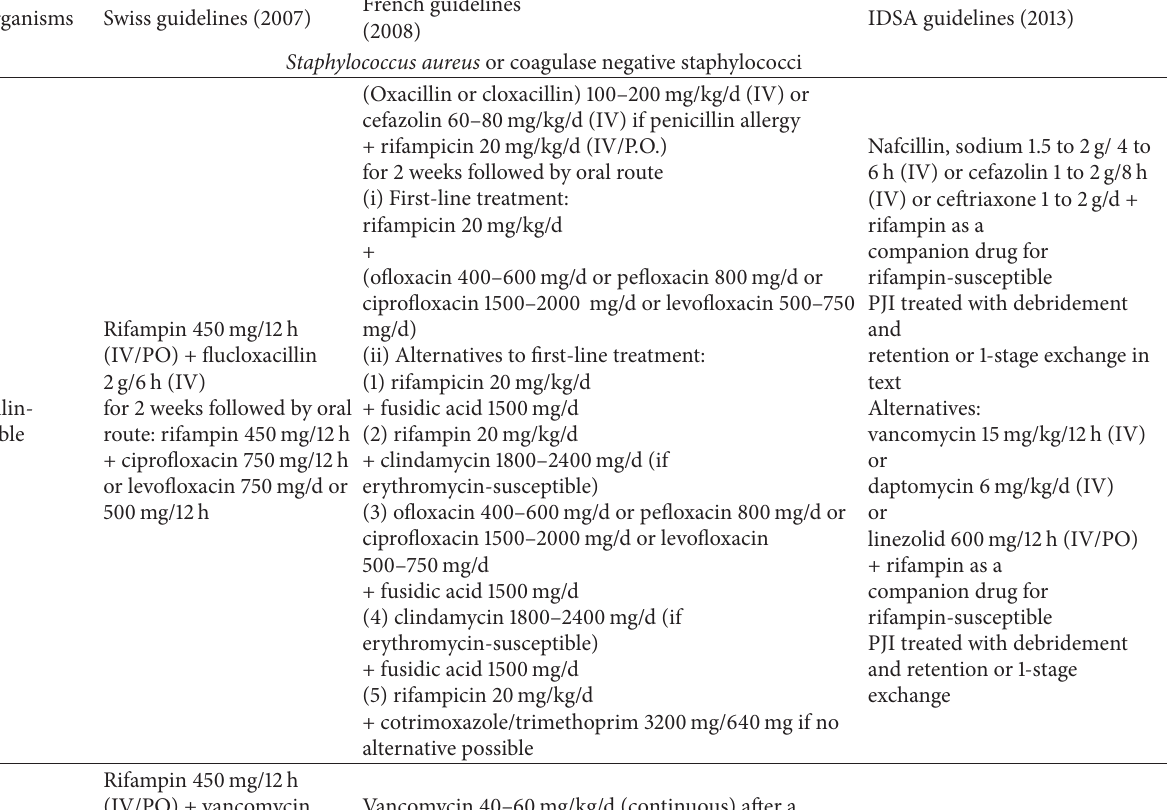
Table 1: European recommendations and IDSA guidelines in the management of prosthetic joint infections [1, 7, 68].